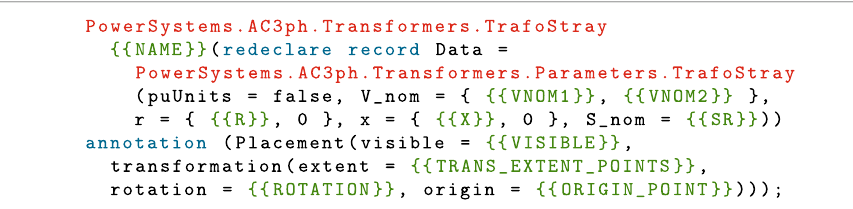
Fig. 9 Listing 5: Transformer subtemplate related to PowerSystems